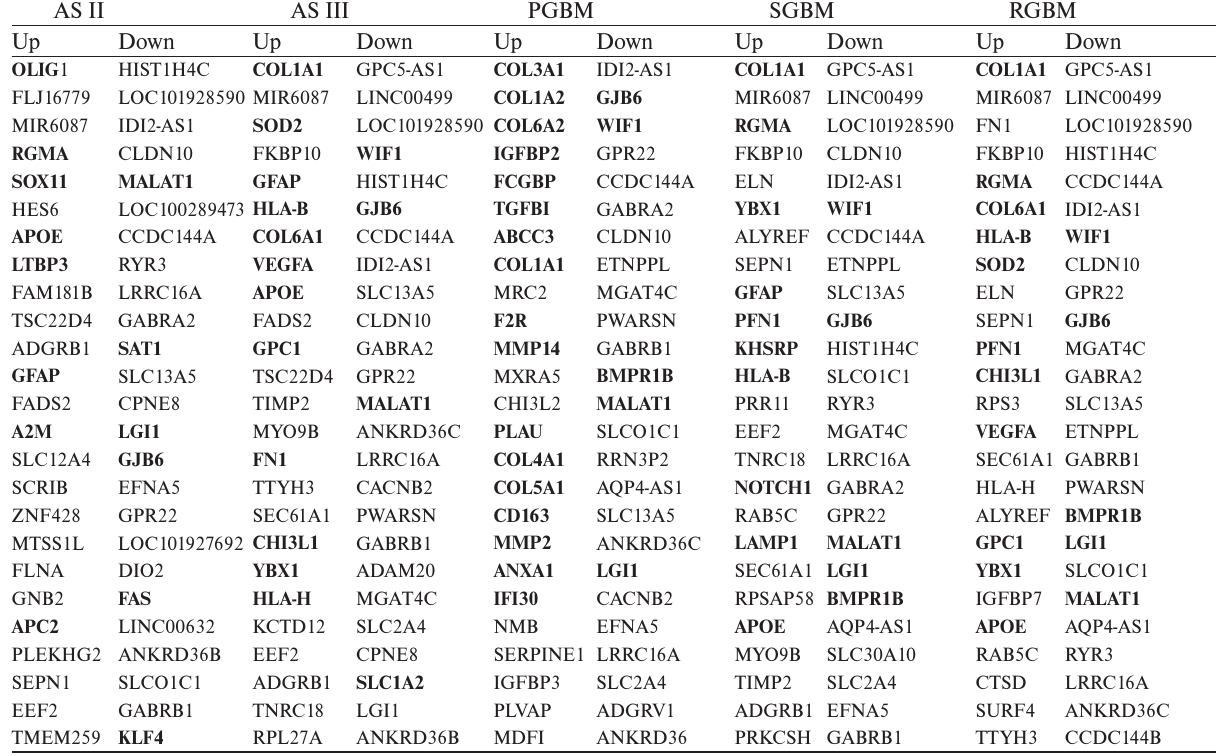
Table 2. List of 25 most significant differentially expressed genes in AS